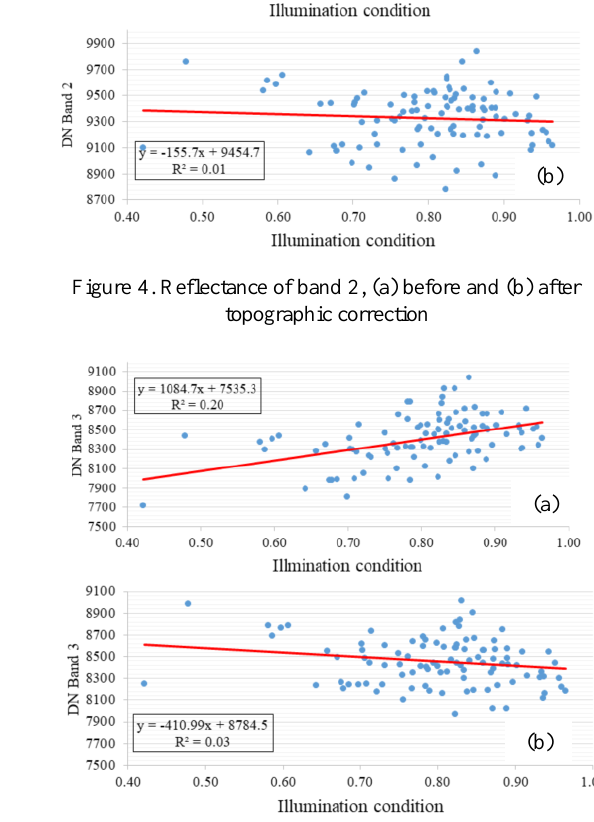
Figure 5. Reflectance of band 3, (a) before and (b) after topographic correction